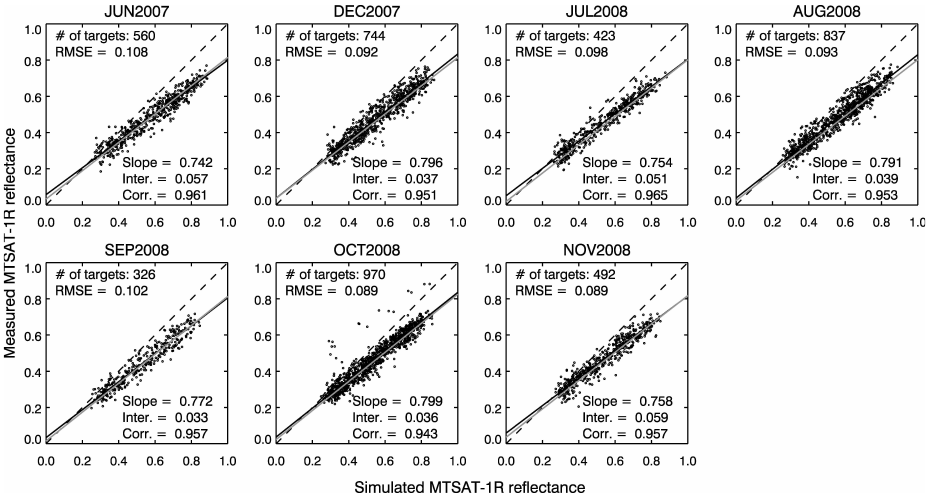
Fig. 12. Same as in Fig. 8 but for the MTSAT-1R 0.724-µm channel (Method 2).